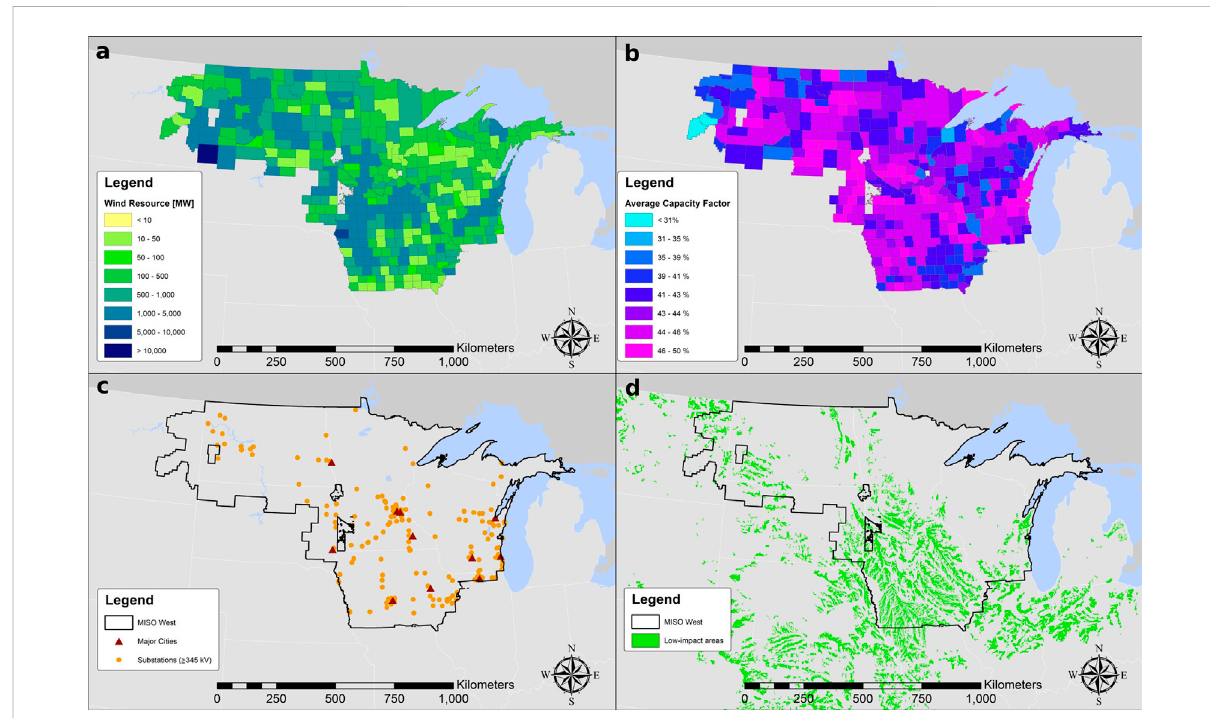
FIGURE 2 MISO West. (A) Wind resource potential tabulated data from NREL WIND Toolkit (Draxl et al., 2015), (B) Wind capacity factor from (Draxl et al., 2015), (C) substations(HomelandInfrastructureFoundation-LevelData(HIFLD,2021b)),andmajorcities(HomelandInfrastructureFoundation-Level Data (HIFLD, 2022a)), and (D) low impact areas from The Nature Conservancy ’ s Site Renewable Right (The Nature Conservancy,